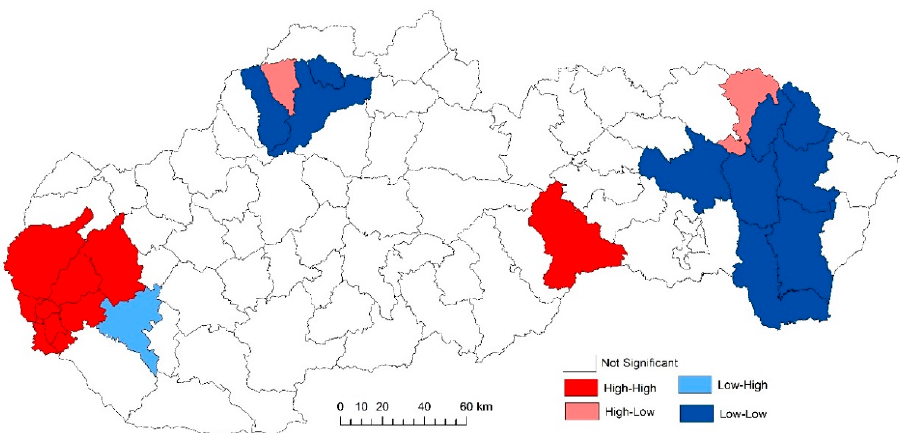
Figure 2. Reginalization of Slovakia based on the local index of spatial autocorrelation (LISA) analysis for standardized death rate of breast cancer per 1000 inhabitants European Standard Population, 2001–2006. Source: Statistical Office of the Slovak Republic, 2019.